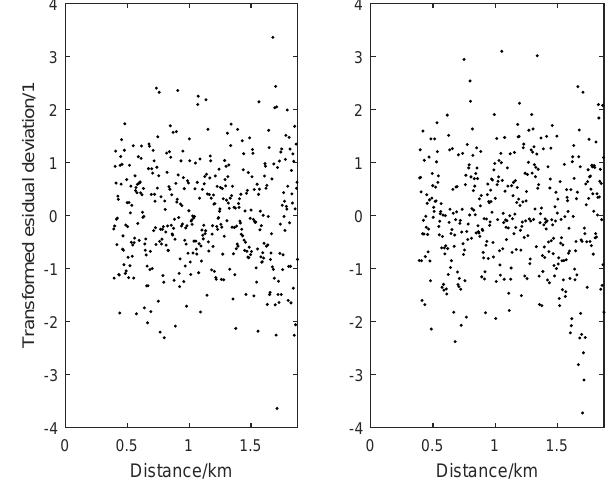
Figure 10. Values of the transformed residual deviations for the signals at (left) the off-resonant wavelength, and (right) the on- resonant wavelength, for the results of the GLS approach shown in Fig. 9.